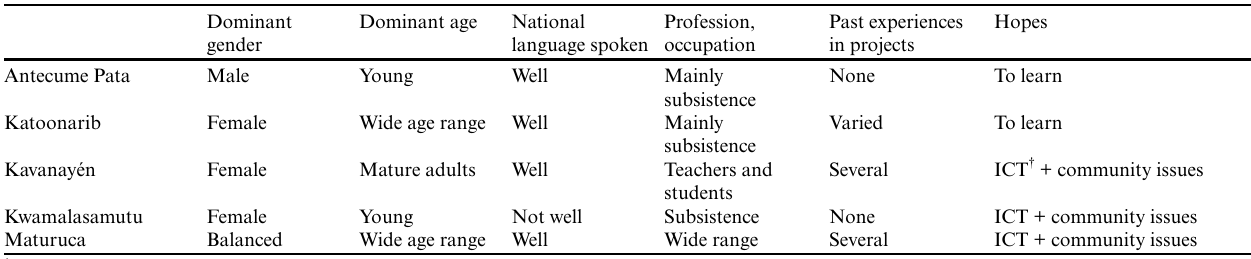
Table 4 . Community participant team